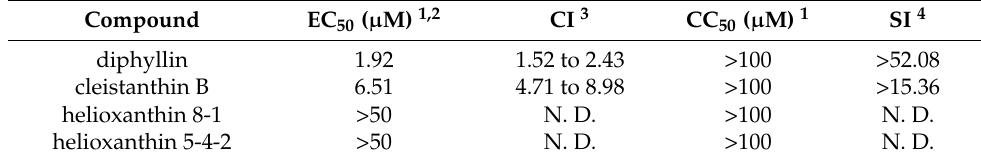
Table 1. Antiviral and cytotoxicity characteristics of diphyllin and cleistanthin B in Vero